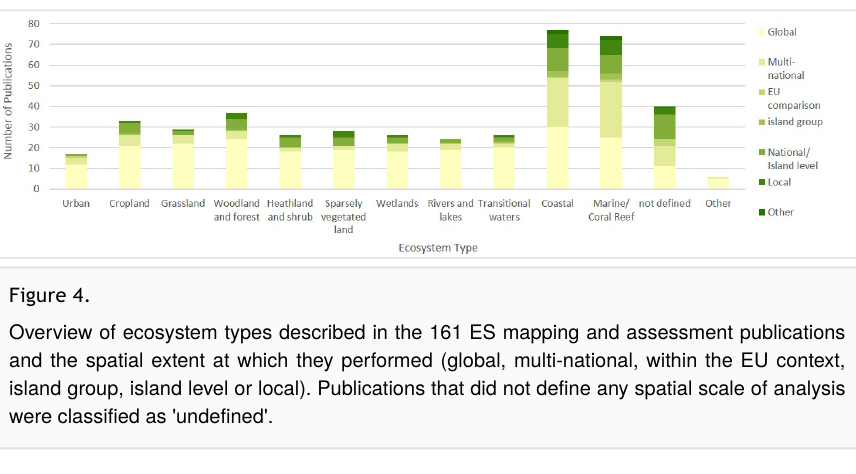
A higher number of studies was expected in the ORs, because of their closer legislative and administrative bonds with their respective EU Member States. However, this expected trend was not con fi rmed by the data. There were no clear di ff erences between numbers of publications on ORs and OCTs or between northern or southern hemisphere. The numbers ranged from 4 publications in Guadeloupe to 18 on the Azores, which was the overall highest number on ES mapping and assessment-related studies in one of the regions considered in this review.